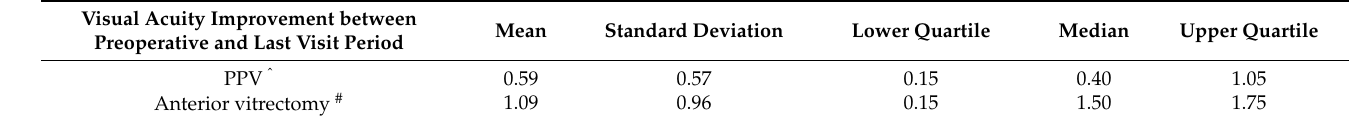
Table 4. Assessment of the visual acuity (logMAR) between the studied periods.